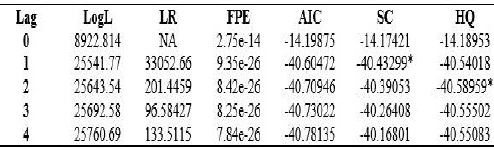
Source: Eviews Software Output